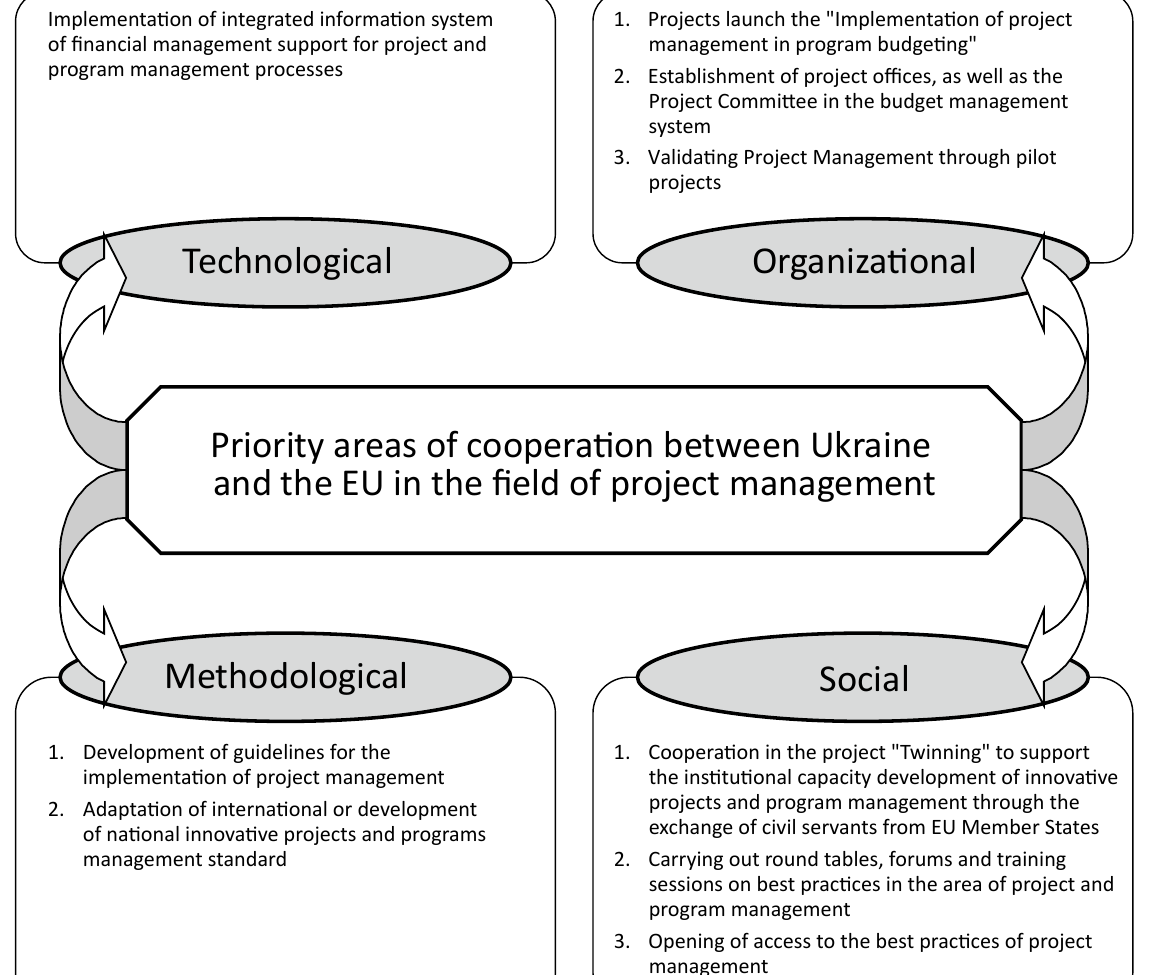
Figure 1. Priority areas of coopera�on between Ukraine and the EU on implementa�on of project management in program-targeted